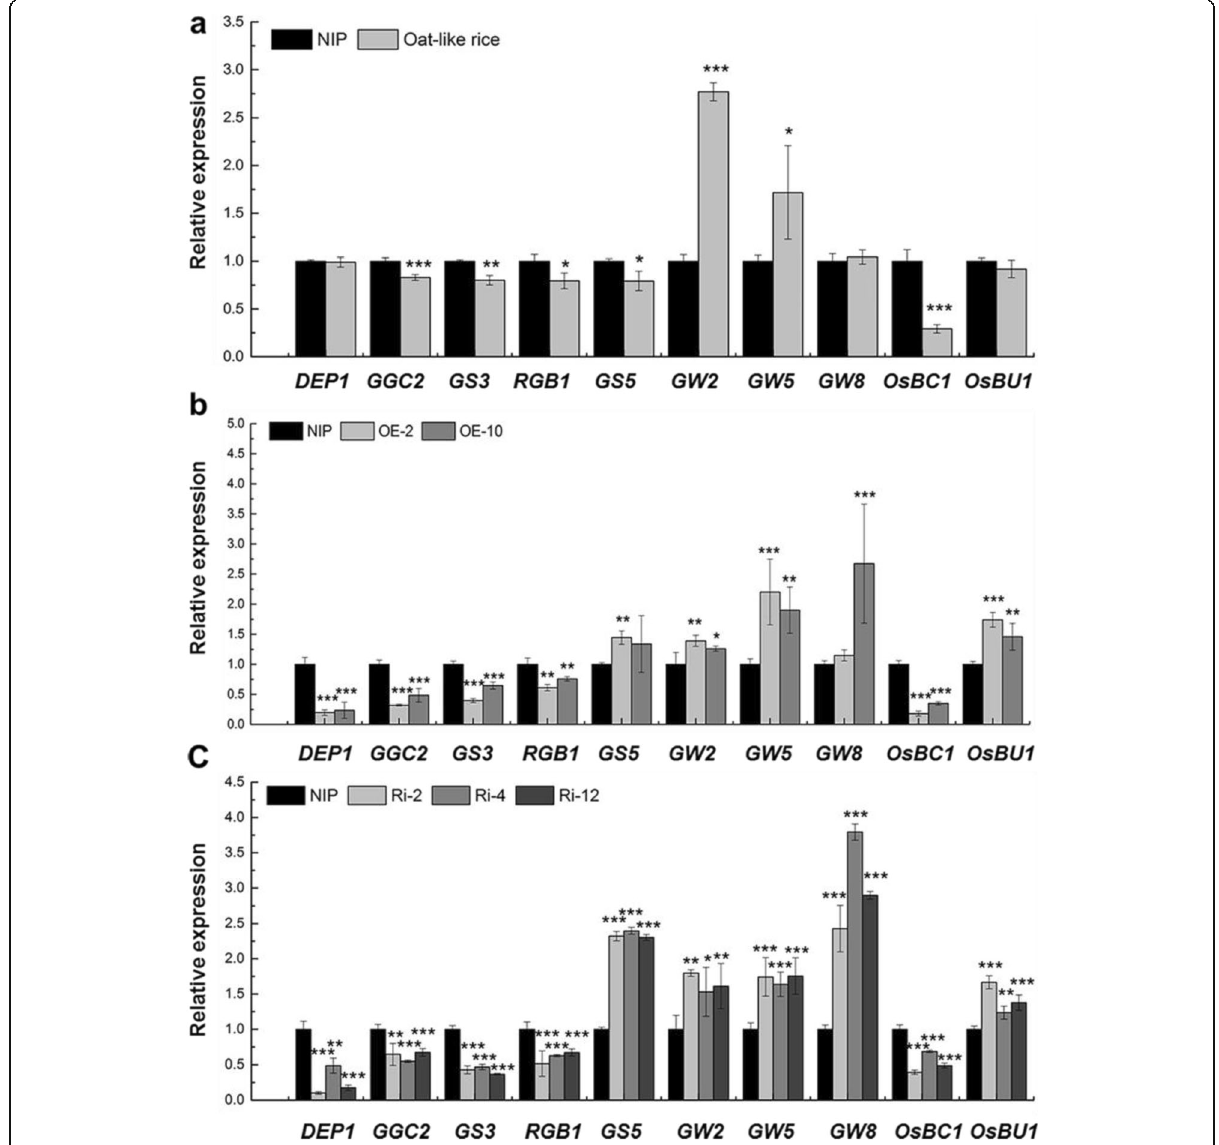
Fig. 10 Expression analysis of representative genes related to grain shape in Oat-like rice, OsMADS1 Olr - overexpressing and OsMADS1 -RNAi plants. a-c Relative expression of representative genes related to grain shape in NIP and Oat-like rice plants ( a ), Os MADS1 Olr - overexpressing plants ( b ) and OsMADS1 -RNAi plants ( c ) by qRT-PCR analysis. For each sample, total RNA isolated from 12 DAF grains was used for qRT-PCR analysis. The value of OsActin mRNA was used as an internal control for data normalization, and the expression levels of genes in NIP were set as 1.0 ( a - c ). Values are means ± SDs of three replicates. Student ’ s t -test: * p < 0.05, ** p < 0.01, *** p <